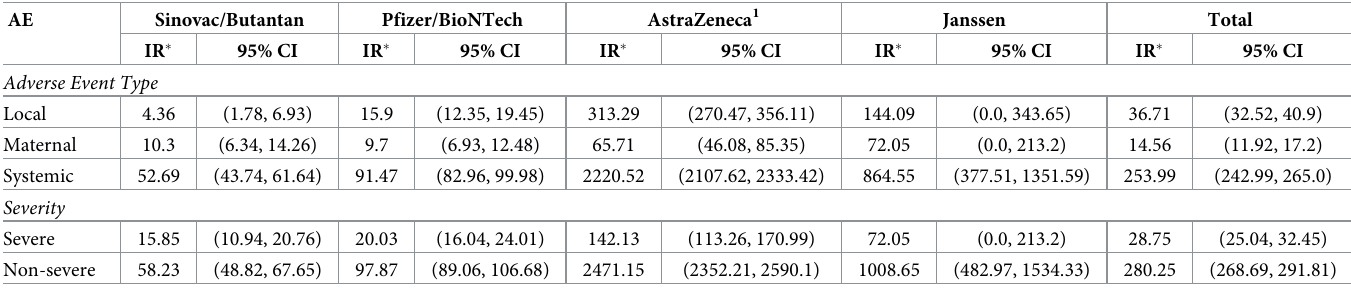
Table 3. Incidence of AE among pregnant and postpartum women according to the type and